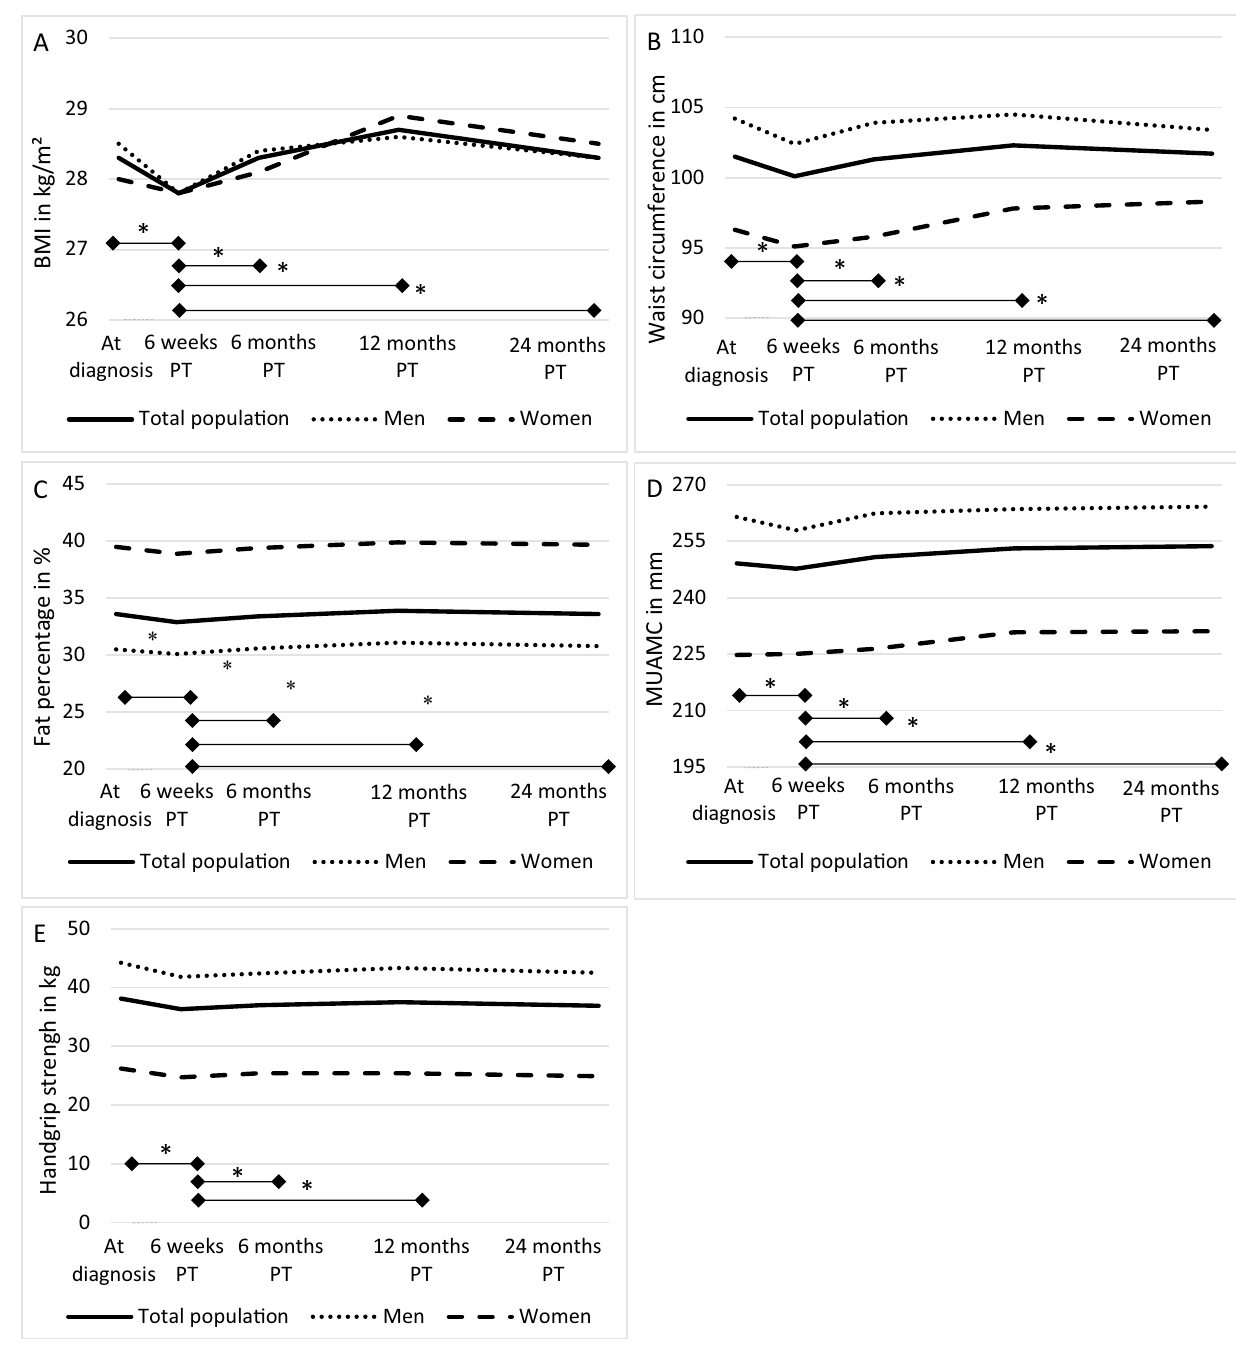
Figure 2. Course of BMI ( A ), waist circumference ( B ), fat percentage ( C ), mid upper arm muscle circumference ( D ), and handgrip strength ( E ) from diagnosis up to 24 months post-treatment (PT) in colorectal cancer survivors in the EnCoRe study. Treatment took place between diagnosis and 6 weeks post-treatment. *Indicates statistically significant differences (p < 0/05) between time points indicated by the horizontal line. BMI body mass index, MUAMC mid upper arm muscle circumference, PT